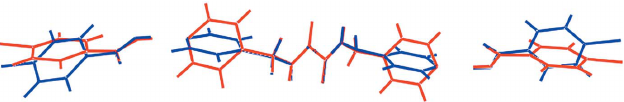
Figure 2 An overlay diagram of the two independent, three-molecule aggregates in (I). The N1-pyridyl/O3-carboxylic acid (red image) and N3-pyridyl/O5- carboxylic acid (blue image) aggregates have been overlapped so that the central C 2 N 2 O 2 chromophores are coincident.